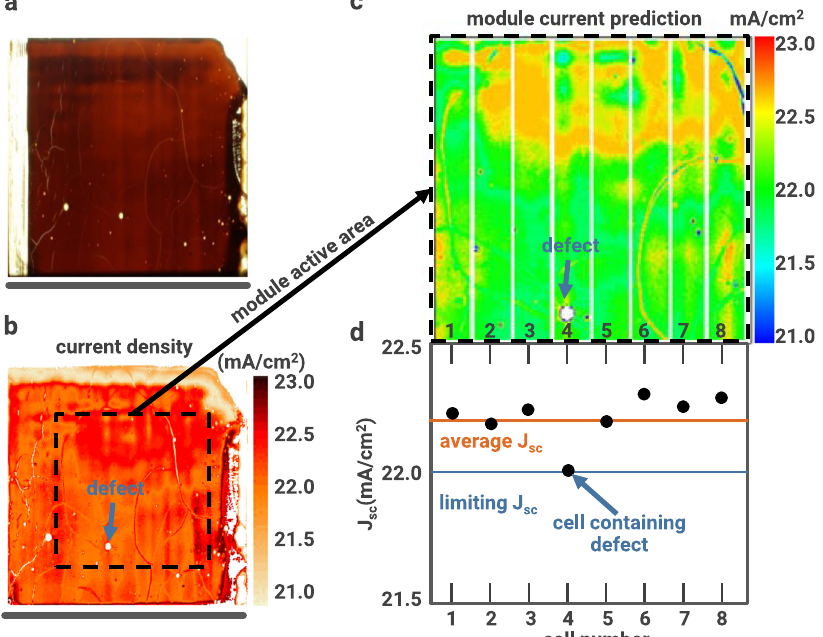
Fig. 4 Predicting perovskite photovoltaic module current density using PerovskiteVision. a Picture of a slot-die coated perovskite fi lm with high coverage ratio but containing morphological defects such as cracks and pinholes. b Map of the predicted photocurrent density over the entire sample. This map is generated by applying the optical model to the perovskite fi lm thickness map. Scale bars indicate 5 cm. c Map of predicted photocurrent density for an 8-cell photovoltaic module that could be fabricated using the perovskite sample shown in panel a . d Average predicted current density for each of the eight cells of the module. The average and minimum J sc across all eight cells are shown in orange and blue, respectively. The module current density would be limited by the current density of the worst-performing cell (in blue), predicted in this case to be cell #4, which contains a large